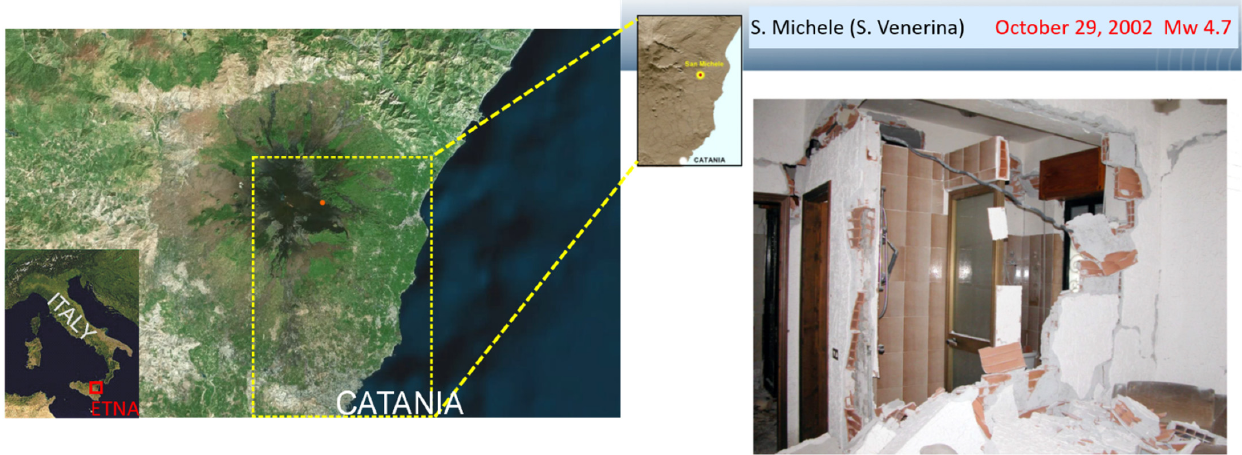
Figure 1. Map of Etna (Italy) and an example of non-structural damage inside a reinforced concrete building due to an Mw 4.7 earthquake in October 2022 (modified from Azzaro et al. [15]).